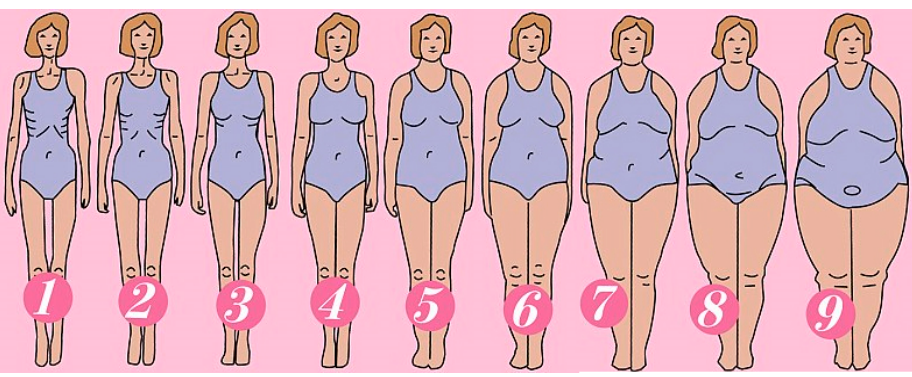
Figure S1: Images used for the thin-sized celebrity treatment group, Figure S2: Images used for the average-sized celebrity treatment group, Figure S3: Images used for the heavy sized celebrity treatment group, Figure S4: Images used for the thin-sized model treatment group, Figure S5: Images used for the average-sized model treatment group, Figure S6: Images used for the heavy-sized model treatment group, Figure S7: Images used for the Control group.